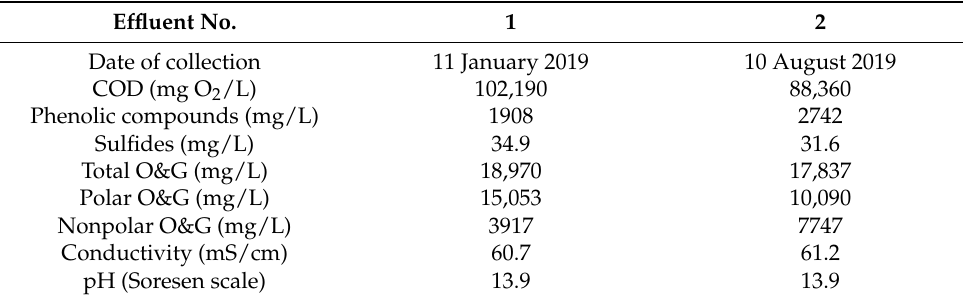
Table 1. Characteristics of spent caustic effluents